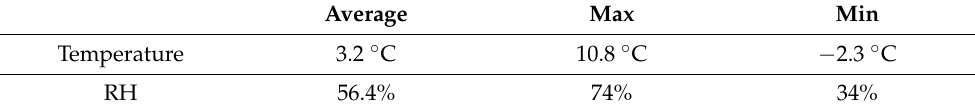
Table 9. Statistics of indoor environmental parameters for W2.